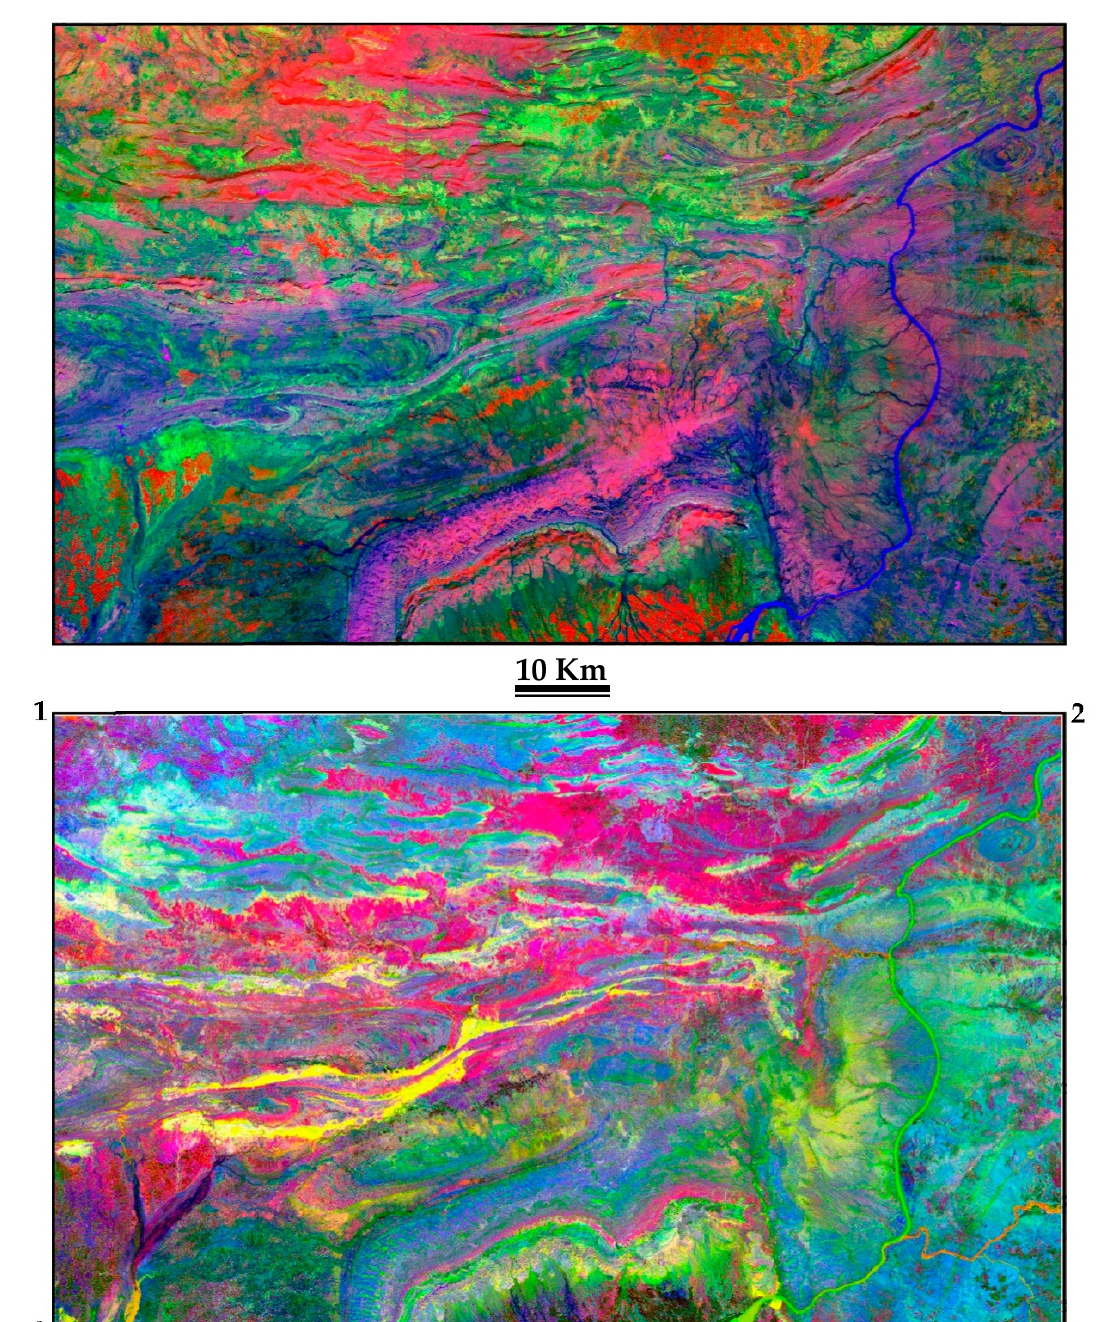
Figure 6. MNF (top) and false-color composite (bottom) of PC components (PC-3, PC-4, and PC-5) of the study area defined by corner points (1) 33 30 ′ 9.83 ″ N, 70 45 ′ 2.05 ″ E; (2) 33 30 ′ 9.83 ″ N, 71 54 ′ 14.87 ″ E; (3) 32 55 ′ 37.63 ″ N, 71 54 ′ 14.87 ″ E; and (4) 32 55 ′ 37.63 ″ N, 70 45 ′ 2.05 ″ E. Samples from the selected polygons were converted into 30 m pixels using GEE built- in function to assign relevant labels before classification, as shown in Table 1. Out of 24,340 pixels, 70% were selected randomly for training, while 30% were used as test dataset to evaluate the machine learning model.